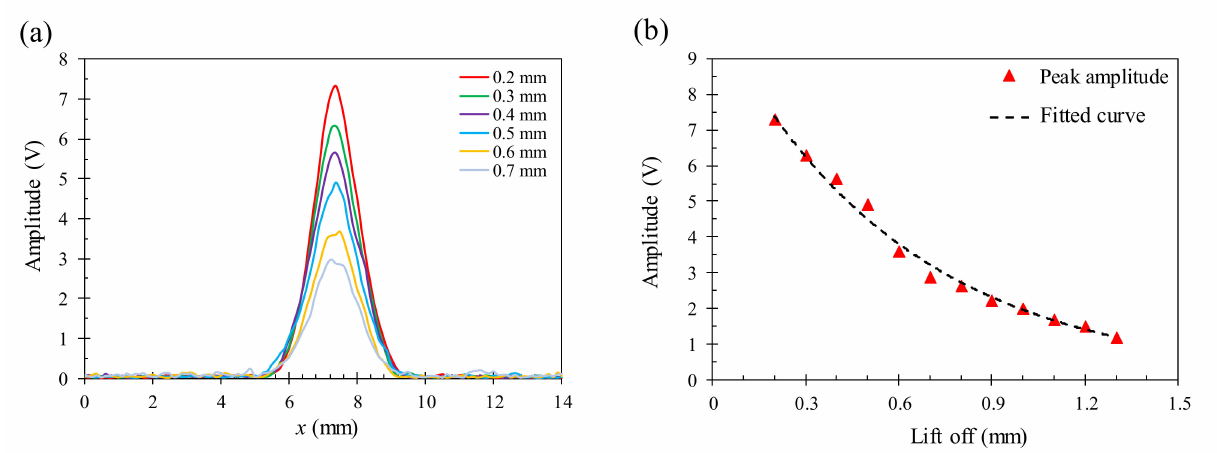
Figure 13. The signal change of the proposed probe on a 1.5 mm deep crack with different lift-off distances from 0.2 to 1.3 mm at the 45 kHz excitation frequency: ( a ) amplitude distribution near the crack, ( b ) reduction in the peak amplitude with increasing